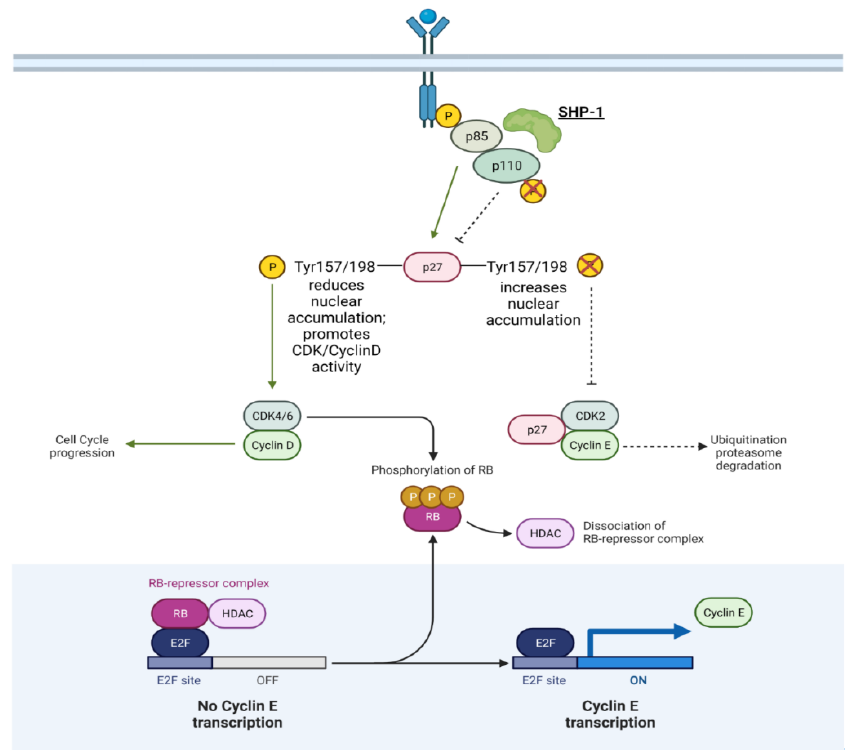
Figure 4. Mechanism of SHP-1 in prostate cancer. For a more in-depth discussion of the mechanism of action, refer to Table 3. Adapted from “G1/S Checkpoint,” by BioRender.com (28 September 2021).